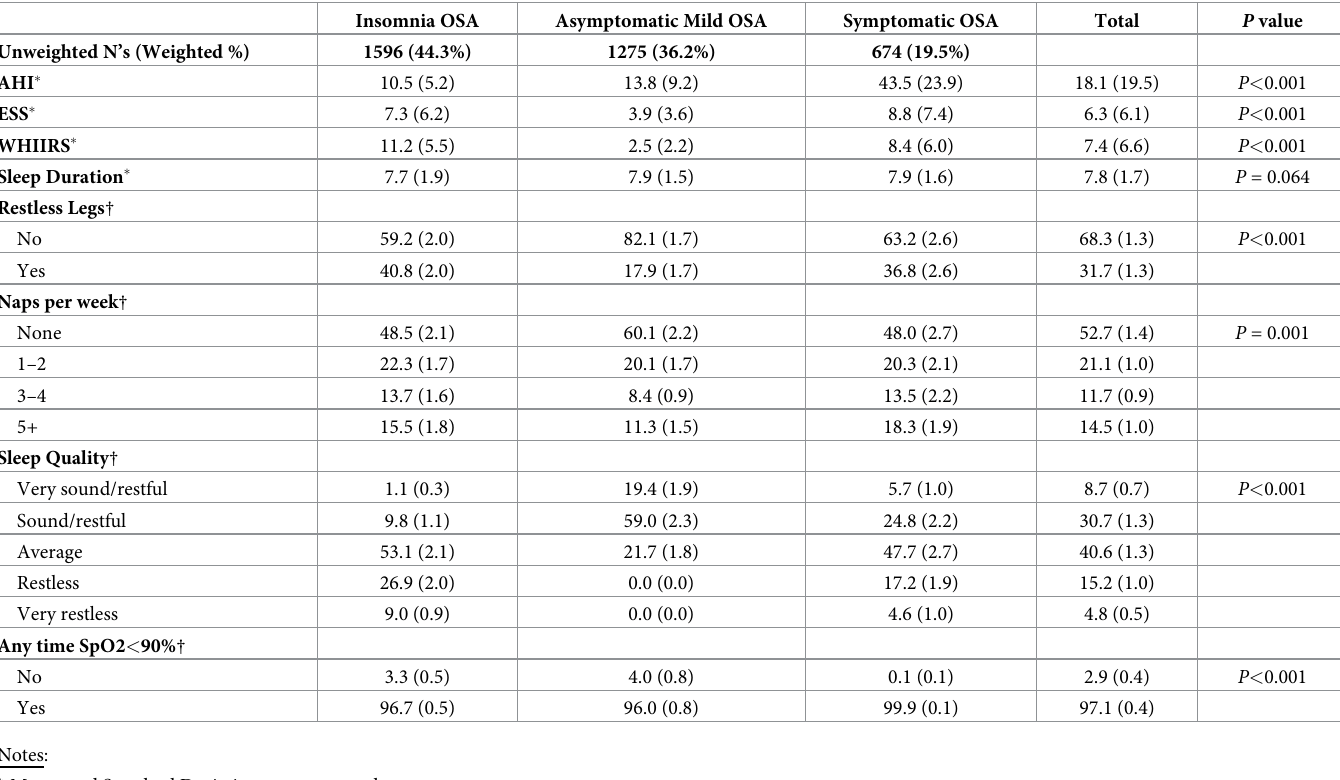
Table 1. Symptom summary of HCHS/SOL individuals for three-group solution with survey design adjustment and subpopulation on Ages 45+ and AHI � 5 (pri- mary solution). Unweighted N =